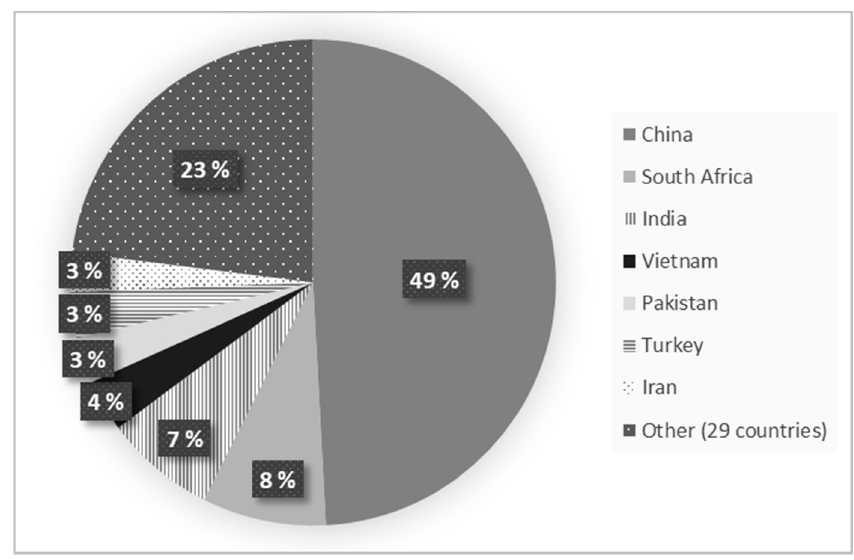
Figure 2. Concrete material supplier distribution by country in Alibaba.com, April 2019.